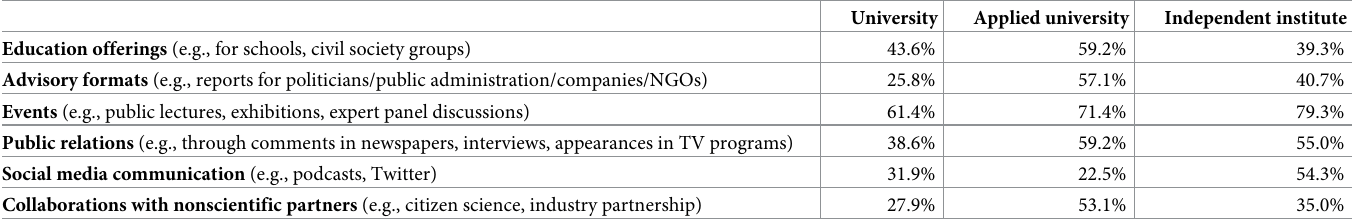
Table 2. Based on the question “which transfer formats have you already used to communicate your results?” The table indicates which transfer formats researchers from the three prevailing institutional types